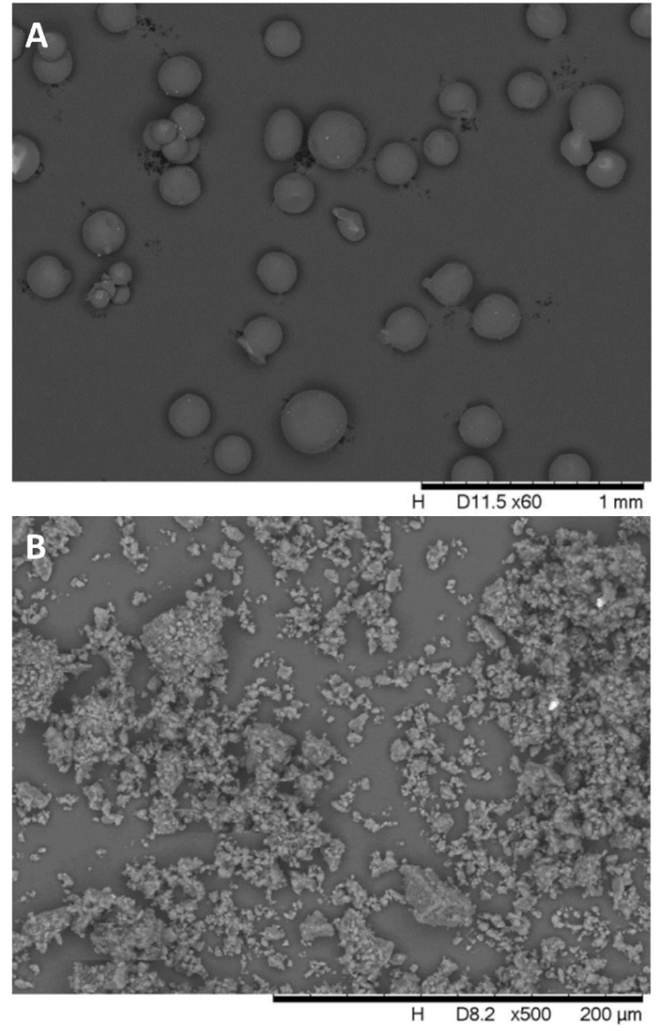
Figure 3 . Scanning electron microscopy images of ( A ) β CDPB and ( B ) β CDPIS carriers. Figure 3. Scanning electron microscopy images of ( A ) β CDPB and ( B ) β CDPIS